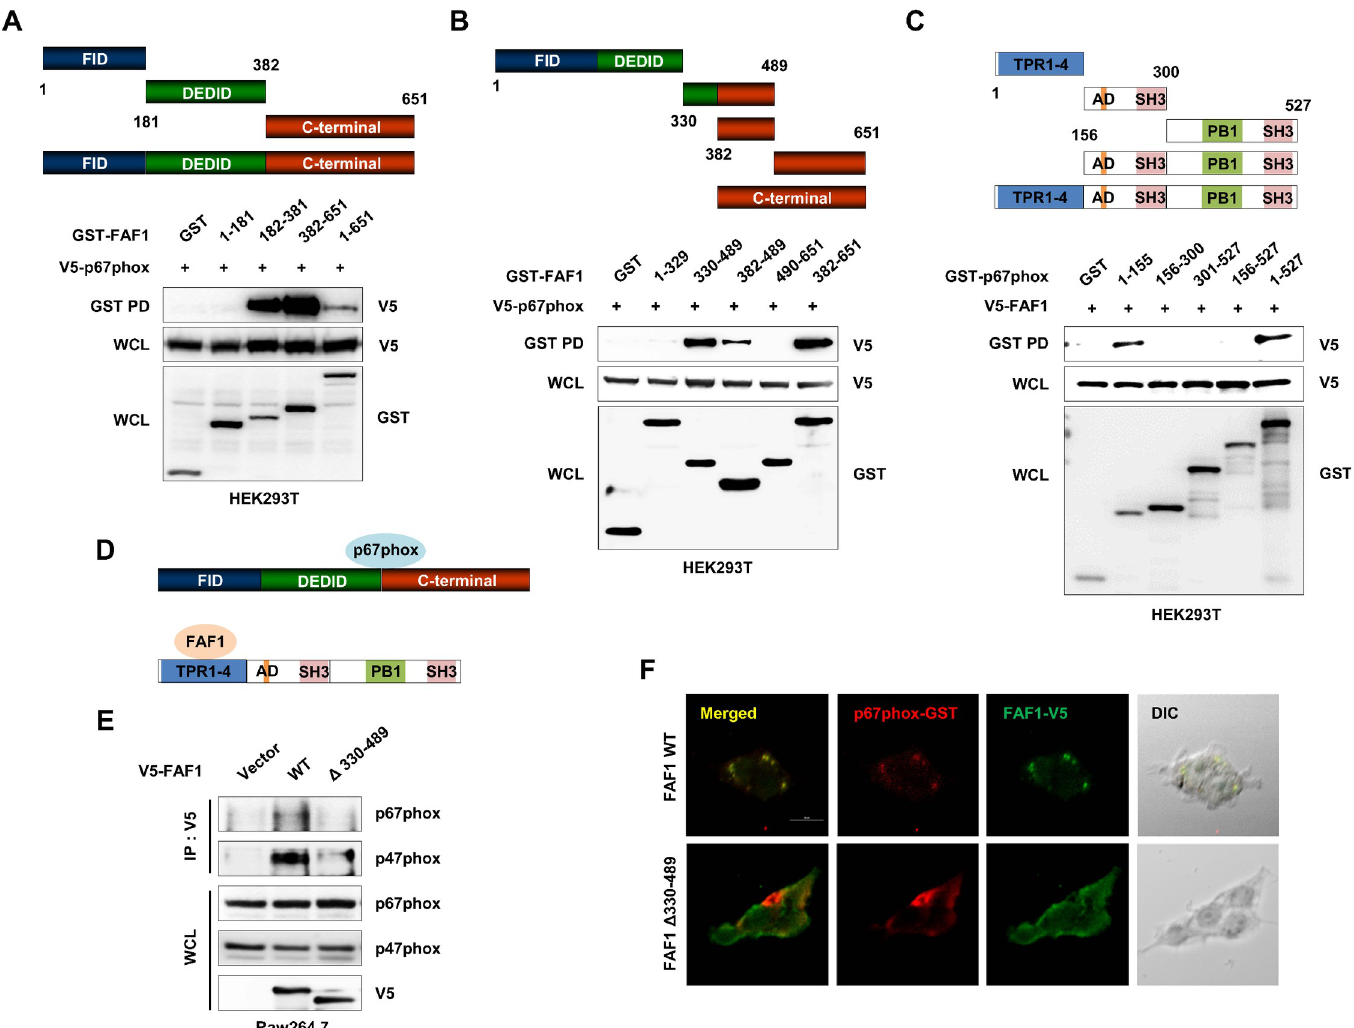
Fig 4. Amino acids 330–489 region of FAF1 is responsible for interaction with p67phox. (A) HEK293T cells were transfected with mammalian GST or GST-tagged FAF1 domain constructs together with V5-tagged p67phox, and at 48hrs, cell lysates were used for GST pull-down assay, followed by immunoblotting with an anti-V5 antibody. (B) HEK293T cells transfected with GST-FAF1 narrow-down domain constructs and V5-tagged p67phox were used for GST pull-down assay. (C) HEK293T cells were transfected with mammalian GST or GST-tagged p67phox domain constructs together with V5-tagged FAF1, and at 48hrs, cell lysates were used for GST pull- down assay, followed by immunoblotting with anti-V5 antibody. (D) Binding mapping. Schematic diagram of FAF1 and p67phox. (E) Raw264.7 cells containing empty vector or V5-tagged FAF1 wild-type or FAF1 Δ 330–489 were used for IP with anti-V5 antibody, followed by immunoblotting with anti-p67phox and p47phox antibodies. (F) HEK293T cells were transfected with V5-tagged FAF1 wild-type or V5-tagged FAF1 Δ 330–489 together with GST-p67phox, followed by confocal microscopy assay with anti-V5 (green) and GST (red) antibodies. Data are representative of two independent